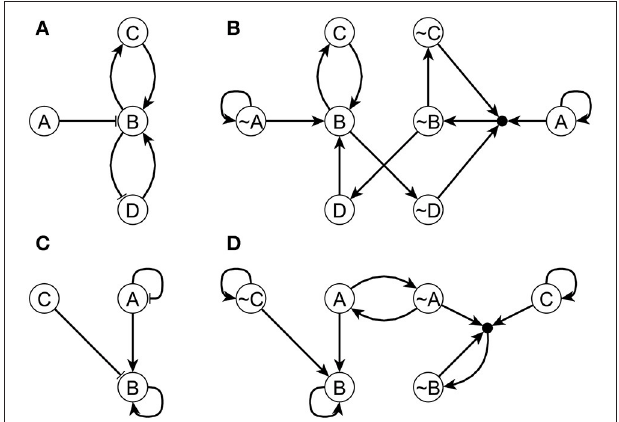
FIGURE 2 | Two example networks (A,C) and their respective expanded networks (B,D) that illustrate the difference between DOI and LDOI. In both networks, an edge with an arrowhead represents activation while an edge with flat bar represents inhibition. Implicit positive self-loops stemming from the assumed sustained states of source nodes are not shown in panels (A,C) . In panel (A) the regulatory functions are f A = A , f B = (NOT A ) OR C OR D , f C = B , f D = NOT B . When A = 1 the system has a fixed point σ B = σ C = 1, σ D = 0. In panel (C) the regulatory functions are f A = NOT A , f B = A OR B OR NOT C , f C = C . When σ C = 1 the system has a complex attractor in which A oscillates and σ B =